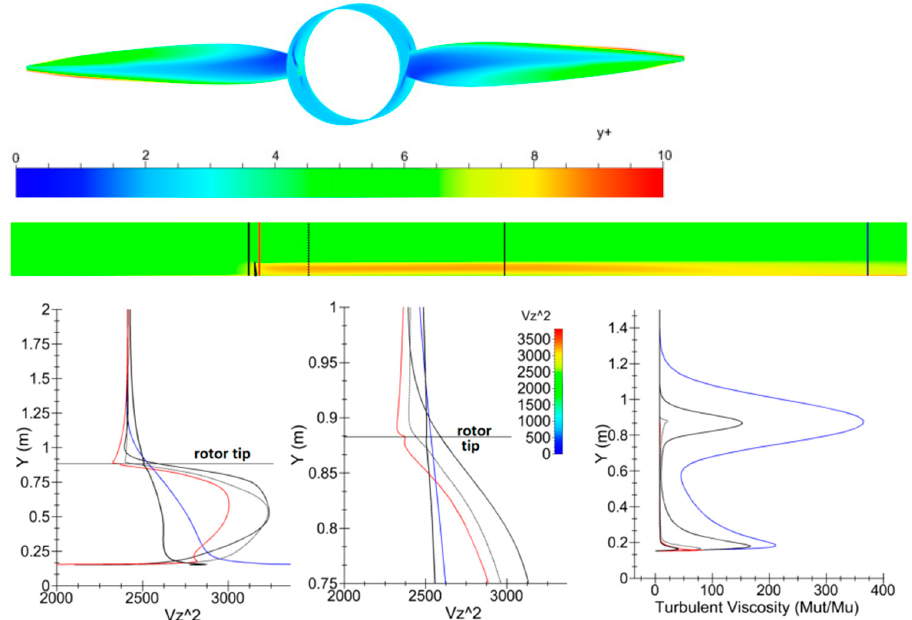
Figure 31. y+ and KE radial plots at several locations downstream of rotor in 3X-40R domain.